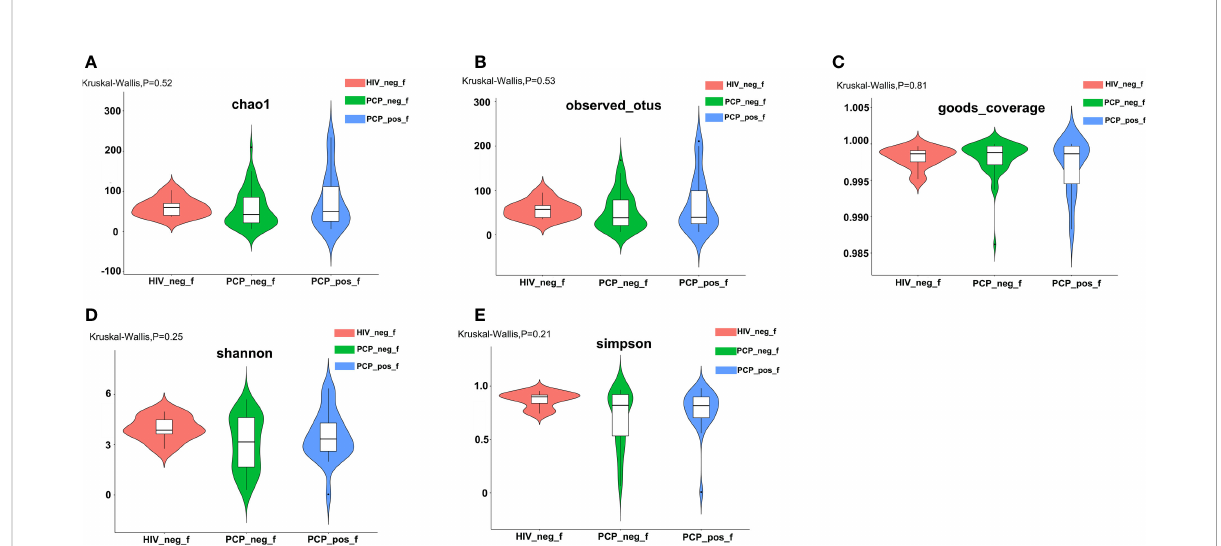
FIGURE 1 Comparison of a -diversity of the gut bacterial community among the three groups. (A) Comparison of the richness of the microbiota in the fecal samples among the three groups based on the Chao1 index (Kruskal-Wallis, p=0.52). (B) Comparison of the richness of the microbiota in the fecal samples among the three groups based on the Observed species index (Kruskal-Wallis, p=0.53). (C) Comparison of the OTU coverage of the microbiota in the fecal samples among the three groups based on the Goods_coverage index (Kruskal-Wallis, p=0.81). OTU: operational taxonomic unit. (D) Comparison of the fecal diversity of the microbiota among the three groups based on the Shannon index (Kruskal-Wallis, p=0.25). (E) Comparison of the fecal diversity of the microbiota among the three groups based on the Simpson index (Kruskal-Wallis,